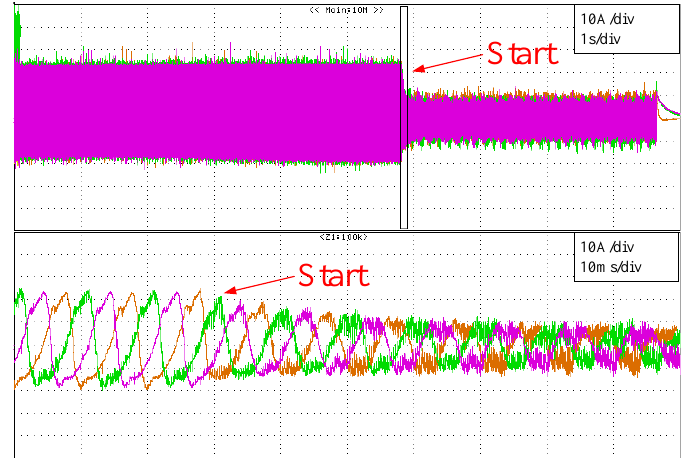
Figure 25. Circulating current with repetitive controllers.